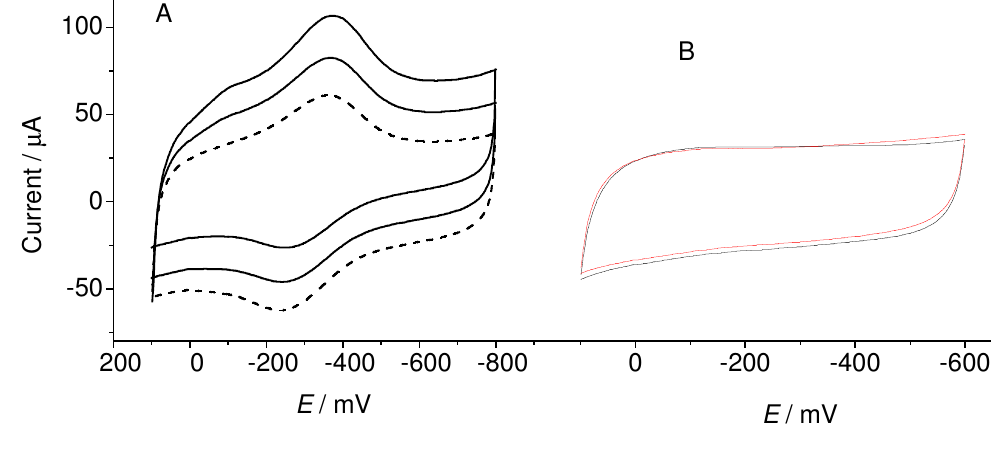
Figure 5 . Cyclic voltammograms of HRP-Au-SPCE (A) and Au-SPCE (B) in 0.1 M pH 7.0 PBS containing 0, 40 and 120 m M H